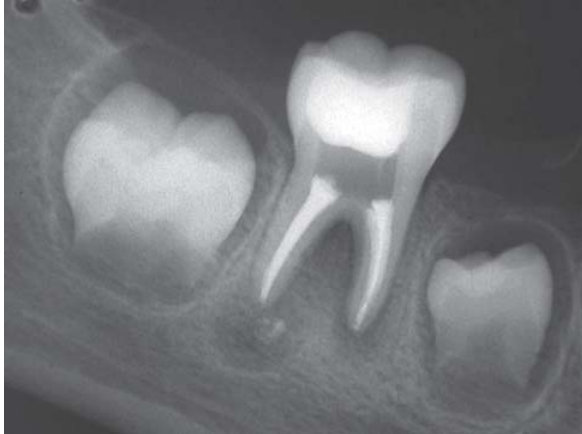
Figure 10- X ray showing small cavity but caries spreading at dentin-enamel junction